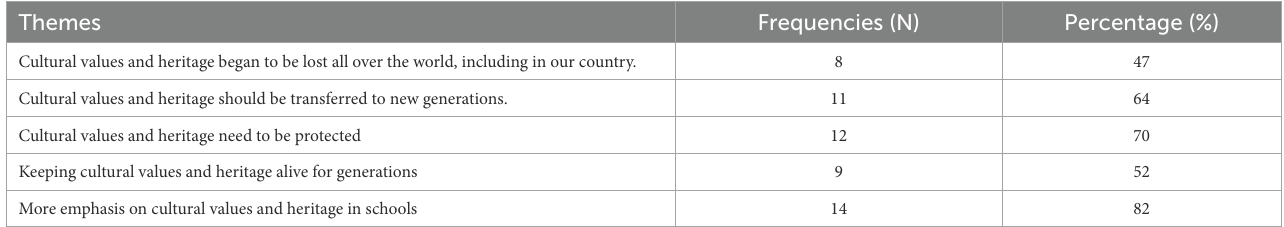
TABLE 1 Sharing of cultural values and heritage based on experts’